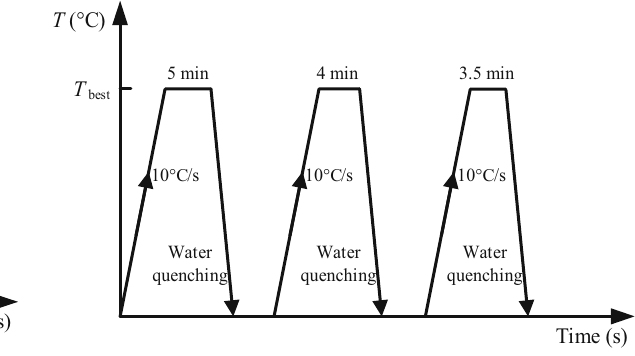
Figure 5: Testing procedures for CHT with decreasing holding time.